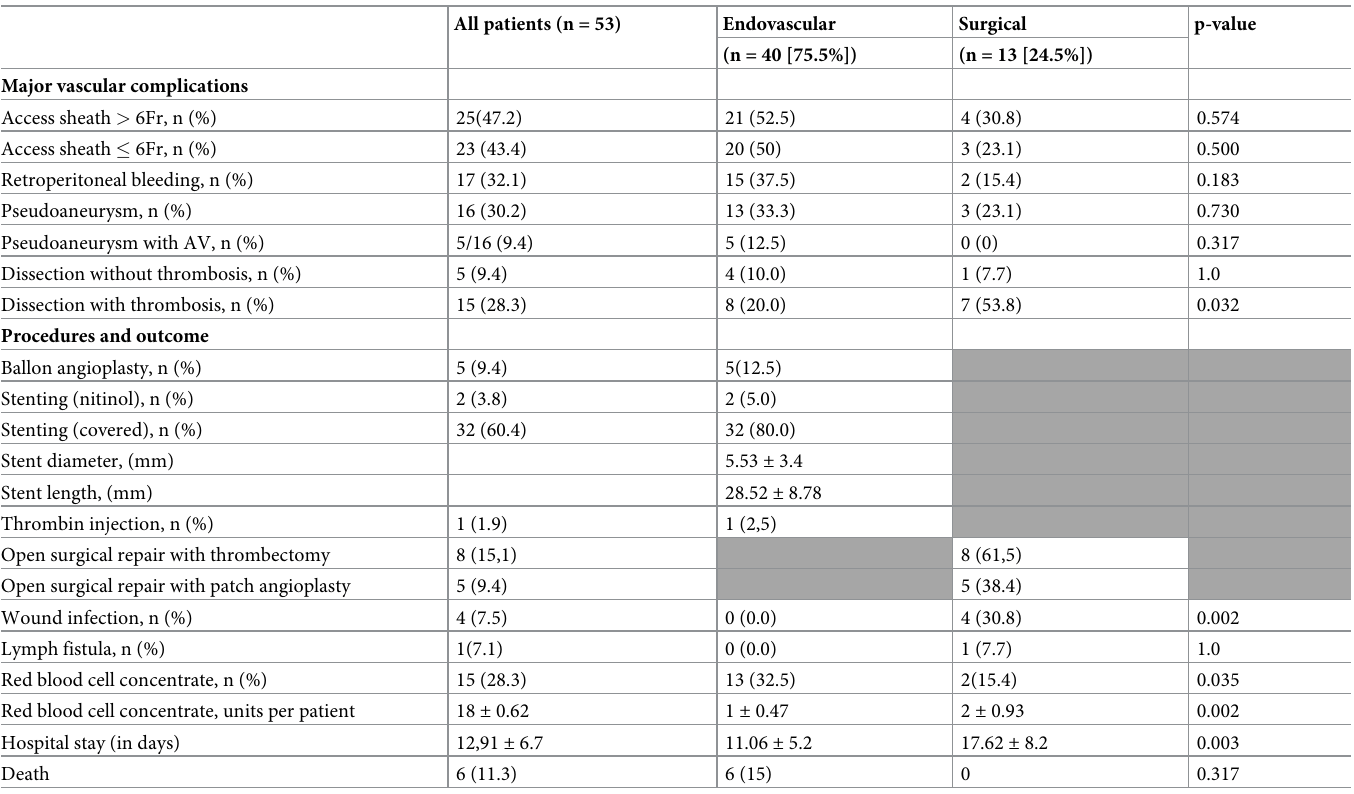
Table 2. Vascular complications and procedural